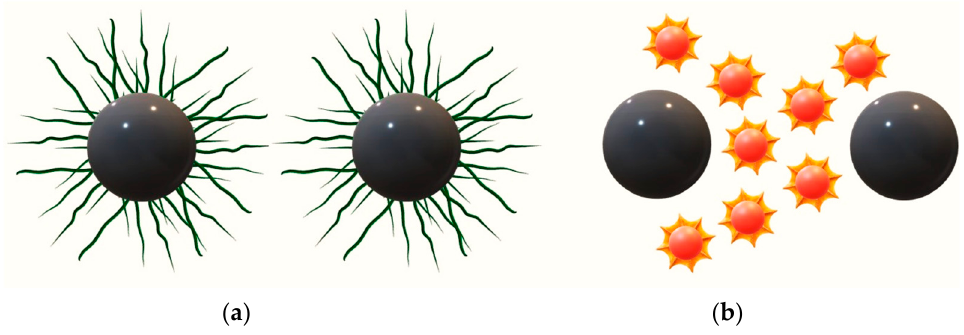
Figure 5. Types of stabilization of particles, i.e., steric ( a ) and depleted ( b ). However, the stabilizing effect of Arabic gum was not sufficient. The particle suspension obtained was polydisperse and contained both micro- and nanoparticles.